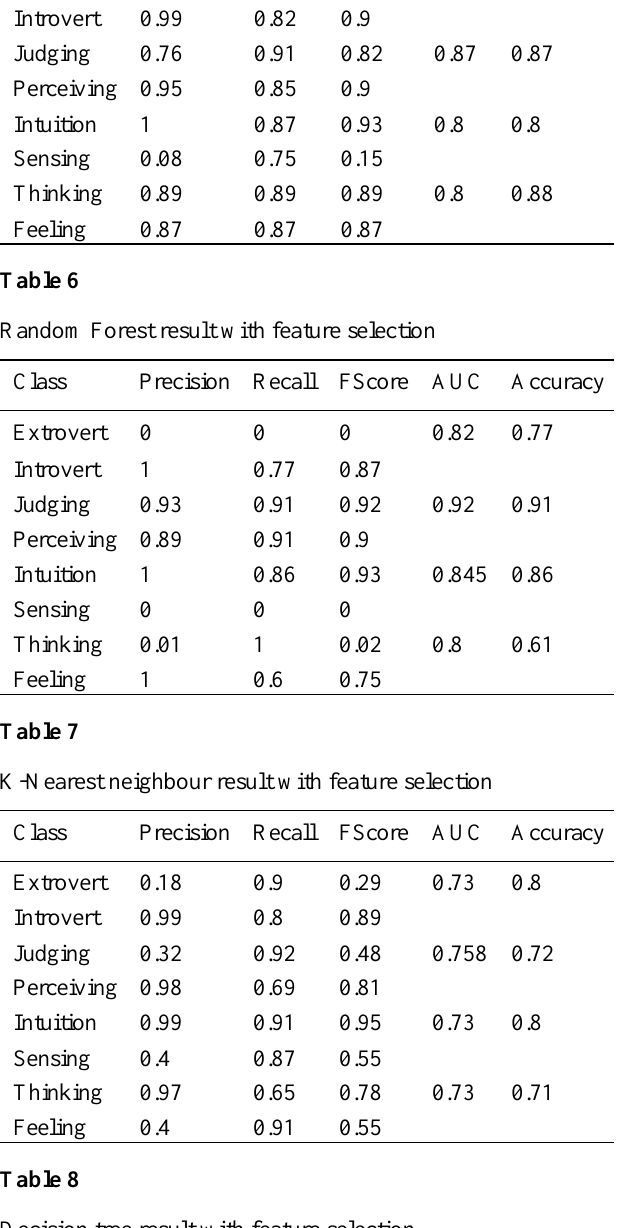
Decision tree result with feature